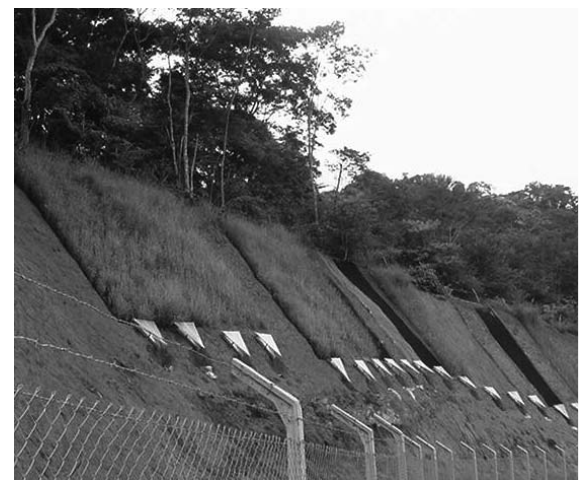
Figura 1. Disposição das parcelas experimentais no talude.